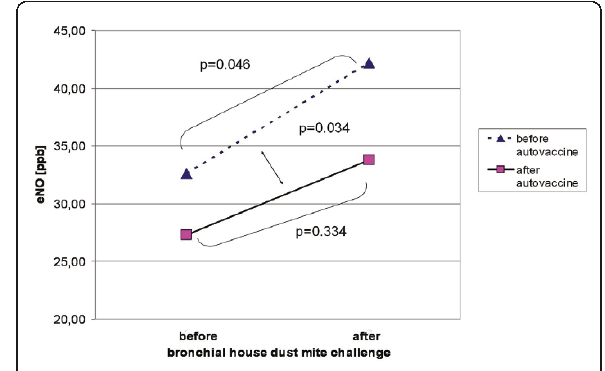
Figure 2 Impact of E.coli autovaccine on exhaled NO as marker of bronchial inflammation in house dust mite allergic asthma. Figure 2 illustrates the increase of exhaled nitric oxide under specific bronchial challenge before and after autovaccine